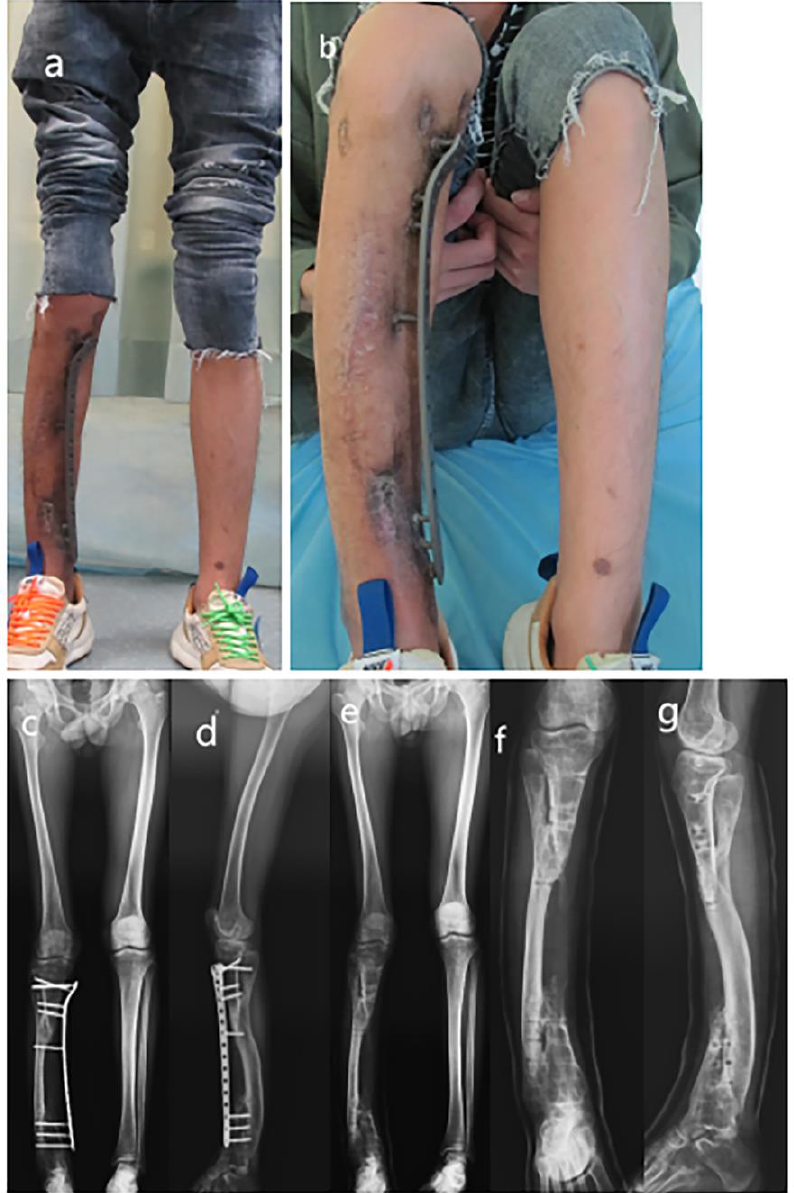
Figure 4. The appearance of the lower extremity and removal of the plate. ( a ) The appearance of the lower extremities; ( b ) Flexion of the knee joint; ( c ) AP view full-length radiograph of lower extremities before plate removal; ( d ) Lateral view full-length radiograph of lower extremities before plate removal; ( e ) AP view full-length radiograph of lower extremities after plate removal; ( f ) AP view radiograph of tibia – fibula after plate removal; ( g ) Lateral view radiograph of tibia – fibula after plate removal.